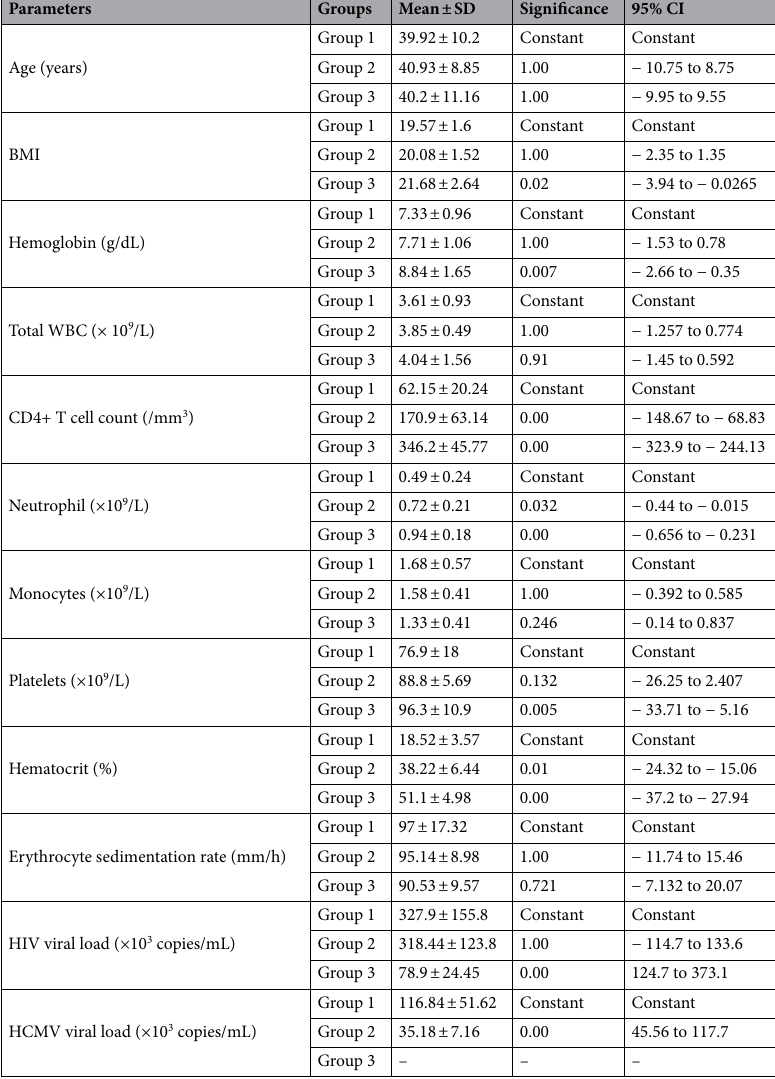
Table 1. A comparative analysis of the demographic and hematological parameters of the patients measured at the time of admission, differentiating Group 1 (N = 26) from Group 2 (N = 25) and Group 3 (N = 25). Mean ± SD values were calculated and one way ANOVA was performed using Bonferroni method (Post-hoc analysis) for comparing the mean values of each group with respect to that of Group